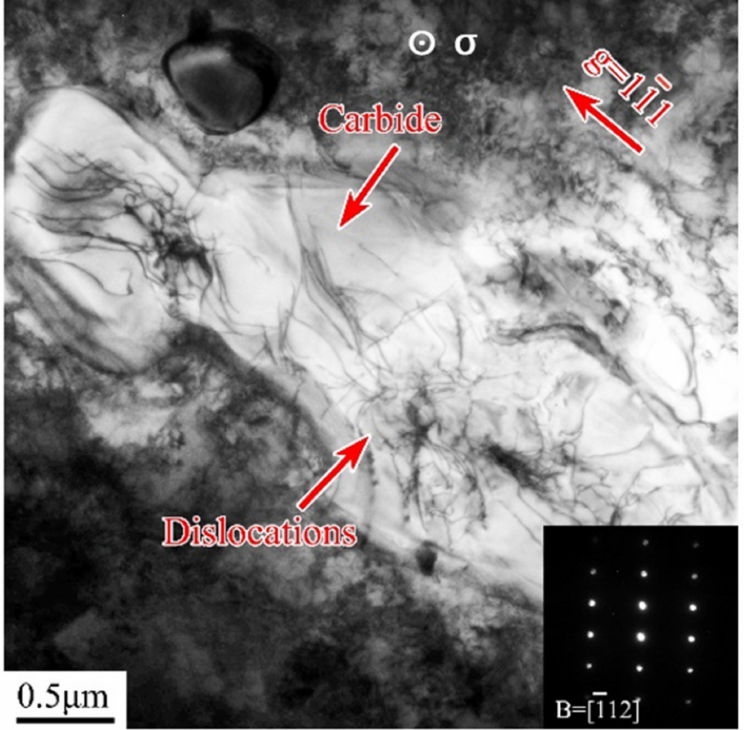
Figure 8. TEM images of typical dislocation configurations in the interdendritic region at the cross sections close to the fracture surface of DZ406 superalloy tested at 1000 ◦